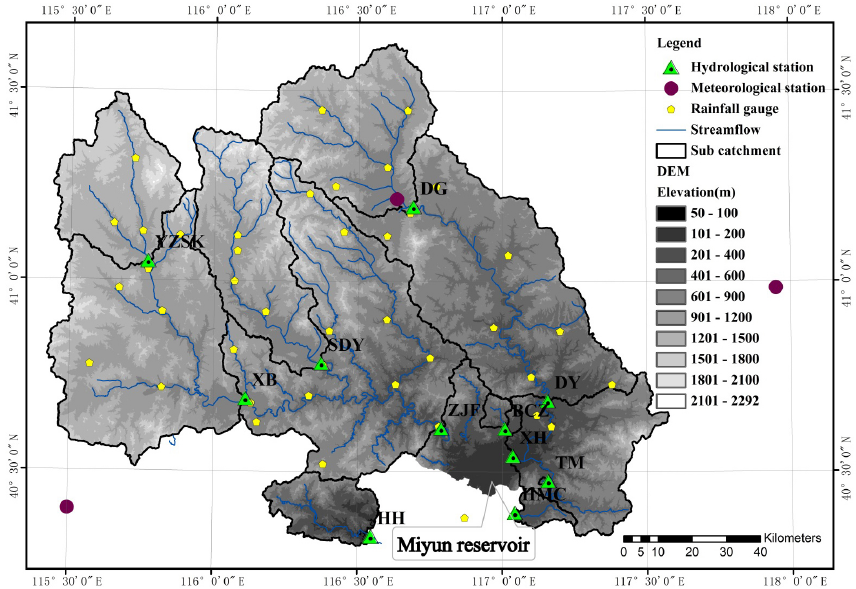
Figure 1. Information of the Miyun Reservoir catchment and sub-catchments including YZSK (Yunzhoushuiku, 1193km 2 ), XB (Xiabao, 3960km 2 ), SDY (Sandaoying, 1536km 2 ), ZJF (Zhangjiafen, 8762km 2 ), DG (Dage, 1660km 2 ), DY (Daiying, 4634km 2 ), XH (Xiahui, 5891km 2 ), HH (Huaihe, 486km 2 ), HMC (Hongmenchuan, 111km 2 ), BCZ (Banchengzi, 65km 2 ), and TM (Tumen, 3km 2